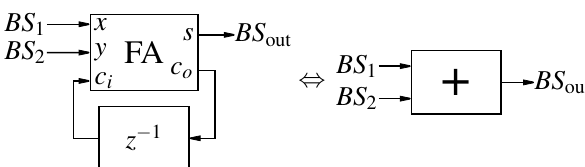
Figure 5. Delta Adder in classical implementation [18] and its corresponding symbol.